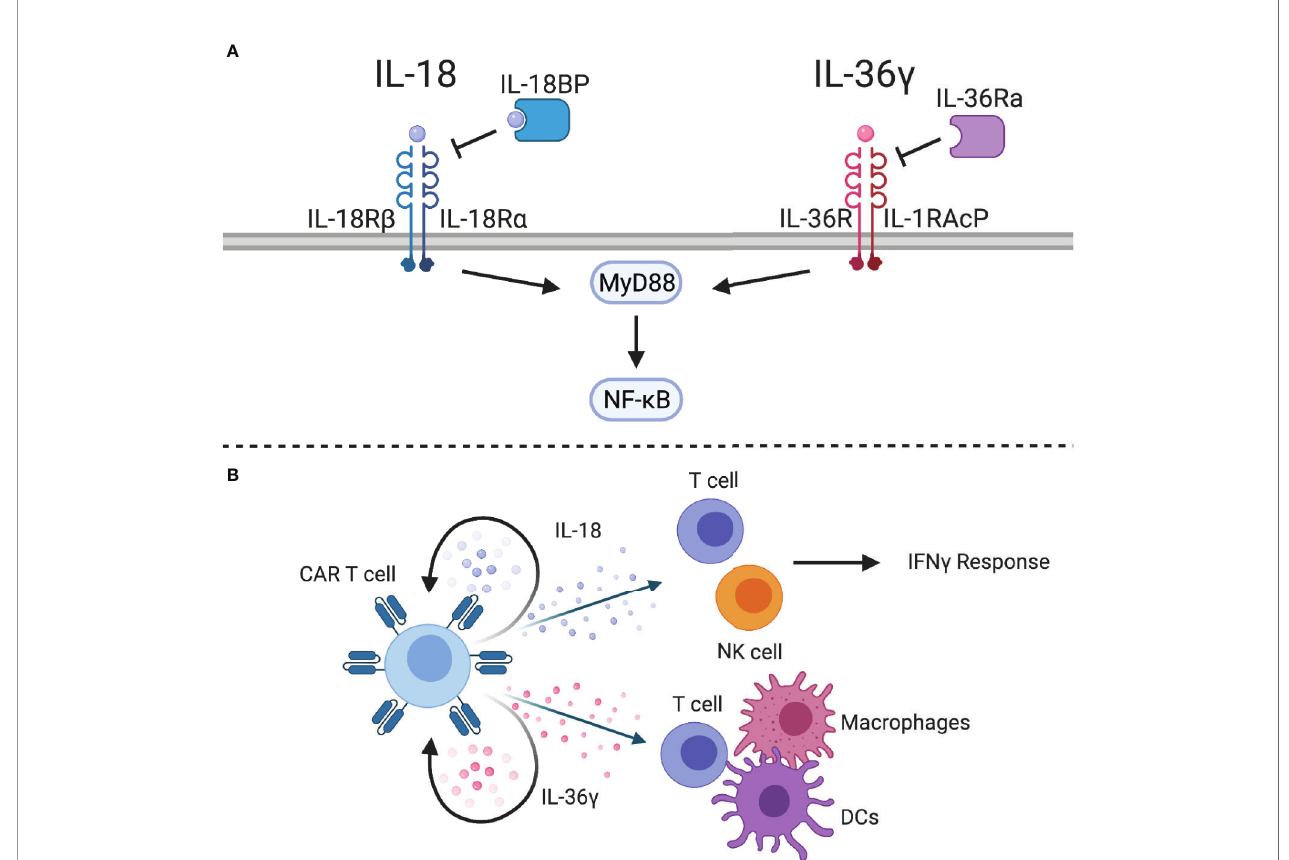
FIGURE 5 | IL-1 superfamily cytokines. (A) The IL-1 superfamily cytokines, IL-18 and IL-36 g , signal through MyD88 to activate NF-kB. Inhibitory proteins, such as IL-18 binding protein (IL-18BP) or IL-36 receptor antagonist (IL-36Ra), can inhibit cytokine signaling. (B) IL-18-expressing CAR T cells can stimulate an IFN g response from CAR T cells and endogenous T and NK cells. IL-36 g -expressing CAR T cells can provide autocrine signaling to enhance effector function and activate endogenous T cells, macrophages, and